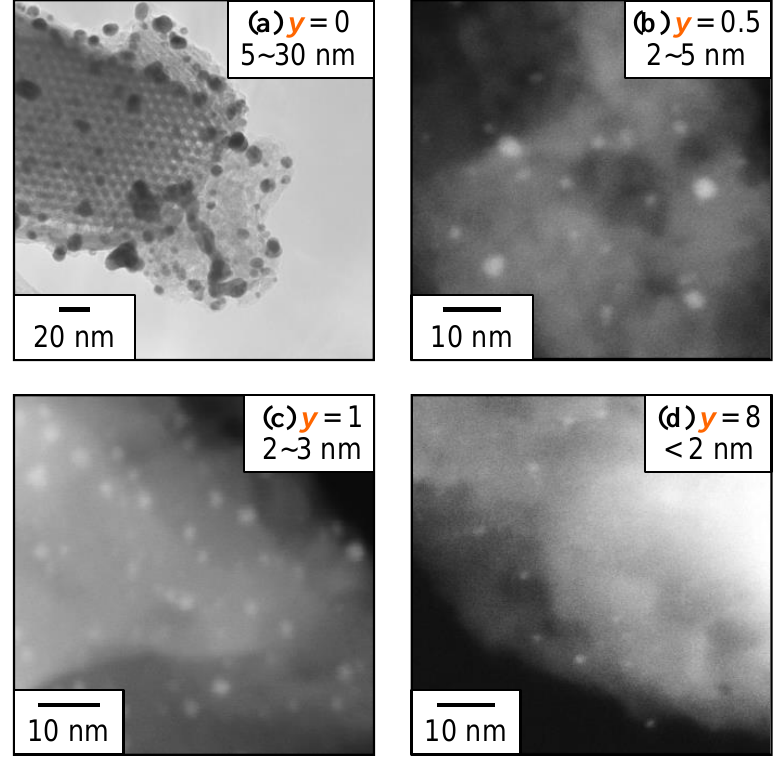
Figure 3. TEM ( a ) and STEM ( b – d ) images of Au/Ti(0.5)-SBA SH ( y ) with y = 0, 0.5, 1, and 8. The structures of the Au sites of the catalysts and their precursors (non-reduced Au ions immobilized) were analyzed by EXAFS (Figure 4). On the precursors, Au – S bonds were observed. On the lower thiol functionalized support ( y = 0.5), the reduction with NaBH 4 led to reducing the Au – S bonds, whereas an increase in the Au – Au bonds was due to the formation of the Au nano-particles. In contrast, many Au – S bonds remained on the higher thiol-functionalized support ( y = 8) even after the treatment with NaBH 4 . A small extent of Au – Au bonds appeared, and, therefore, strong Au – S interaction would prevent the forming of the Au clusters. Electronic states of the resulting Au species were also var- ied according to the amounts of the alkylthiol loadings y . On the support with y = 0.5, the binding energy of XPS of the formed Au particles was slightly shifted to lower compared to that of the metallic Au formed on the non-thiol-functionalized support ( y = 0). In con- trast, increasing the thiol functionalities ( y = 8) yielded cationic Au with higher binding energy as found in Figure 5.